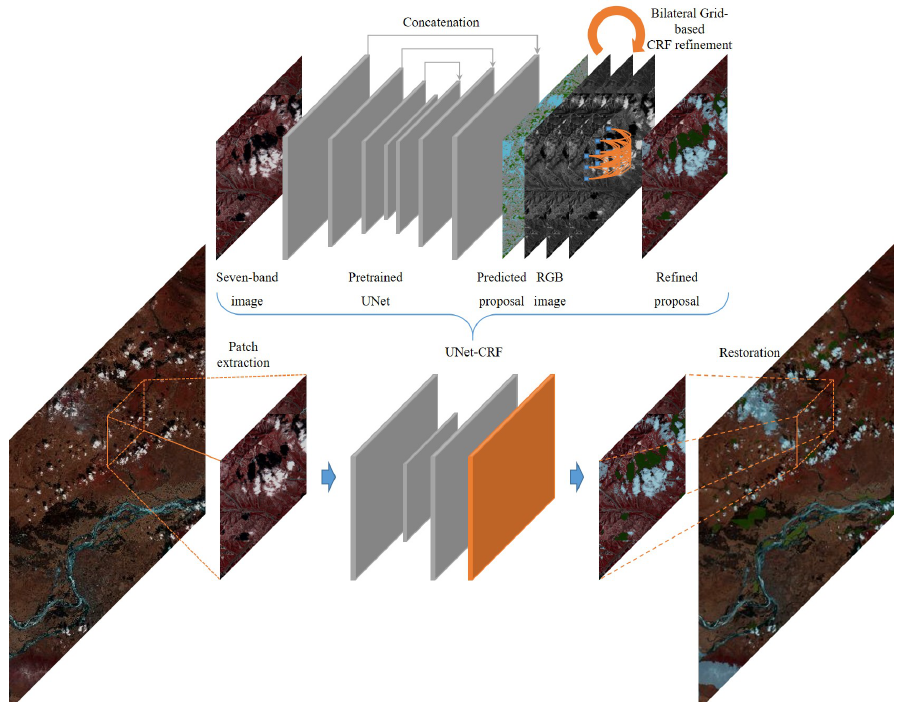
Figure 2. Illustration of the overall framework of Refined UNet v4. The UNet-CRF architecture copes with local patches extracted from original full images: the pretrained UNet yields predicted segmentation proposals while the embedded CRF layer refines the edges. Full refined proposals are finally restored from local patches. We make use of the bilateral grid to facilitate the nonlinear bilateral message-passing step, which is equivalent to the Gaussian-form step in Dense CRF